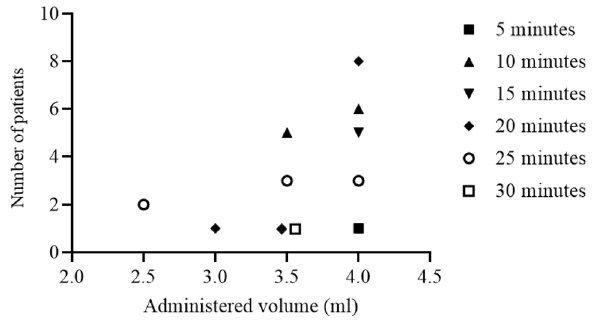
Figure 3. Relation between LA volume and block onset time for successful blocks. A successful block was defined by a score = 2 with a light touch felt on the P2 or P3 of the index